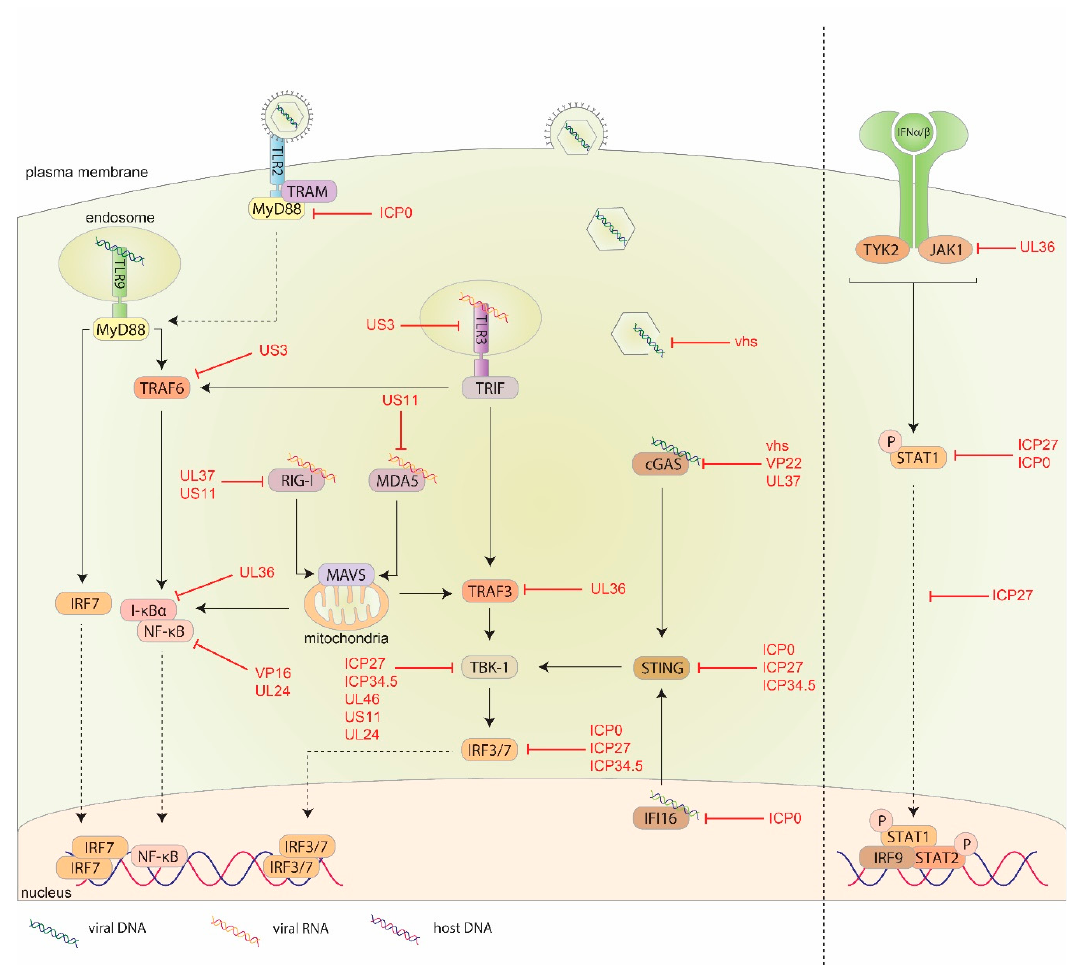
Figure 4. HSV-1 evasion mechanisms to downregulate the host innate immune response. Multiple steps in the downstream signaling pathways following PRR activation are targeted by HSV-1 proteins to limit detection by the innate immune system. HSV-1 can directly inhibit the DNA sensors cGAS and IFI16, and the RNA sensors TLR3, RIG-I and MDA5 as well the accumulation of viral DNA in the cytoplasm. HSV-1 also inhibits downstream signaling molecules including MyD88, TRAF3, TRAF6, I- κ B α , STING, and TBK-1 to prevent the nuclear translocation of IRF3/7 and NF- κ B, preventing IFN and cytokine production. HSV-1 also inhibits IRF3/7 and NF- κ B directly. HSV-1 has also evolved to inhibit the IFN signaling pathway directly, inhibiting JAK1 phosphorylation as well as STAT1 phosphorylation and its translocation to the nucleus, downregulating ISG production. Solid lines represent downstream activation, dashed lines represent translocation.